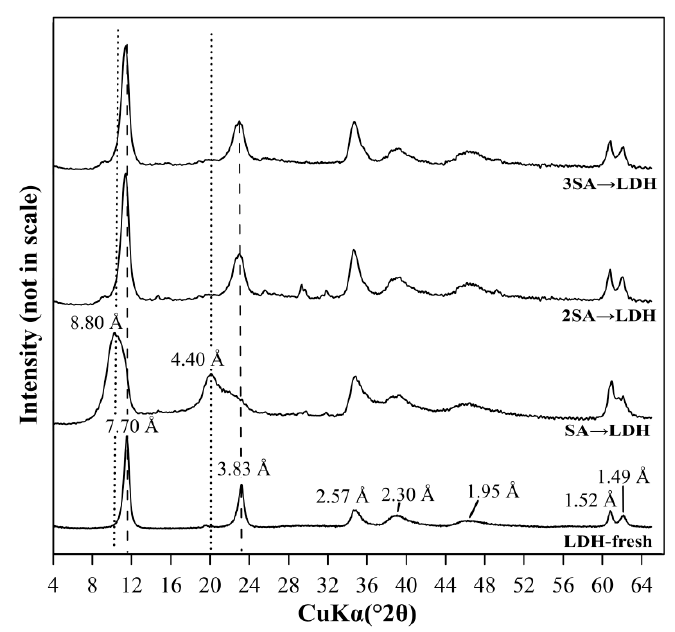
Figure 8. The XRD patterns of LDH, before (LDH-fresh) and after AMD treatment in a two-step treatment process.